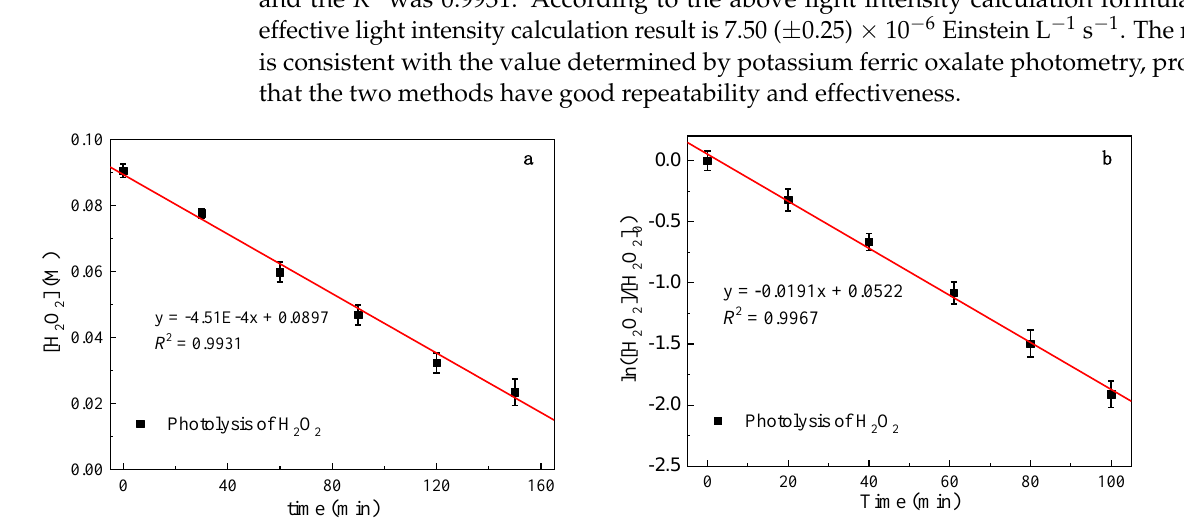
Figure 2. High ( a ) and low ( b ) concentration photolysis of H 2 O 2 . Photodegradation experimental results of low concentration H 2 O 2 in the photochem-